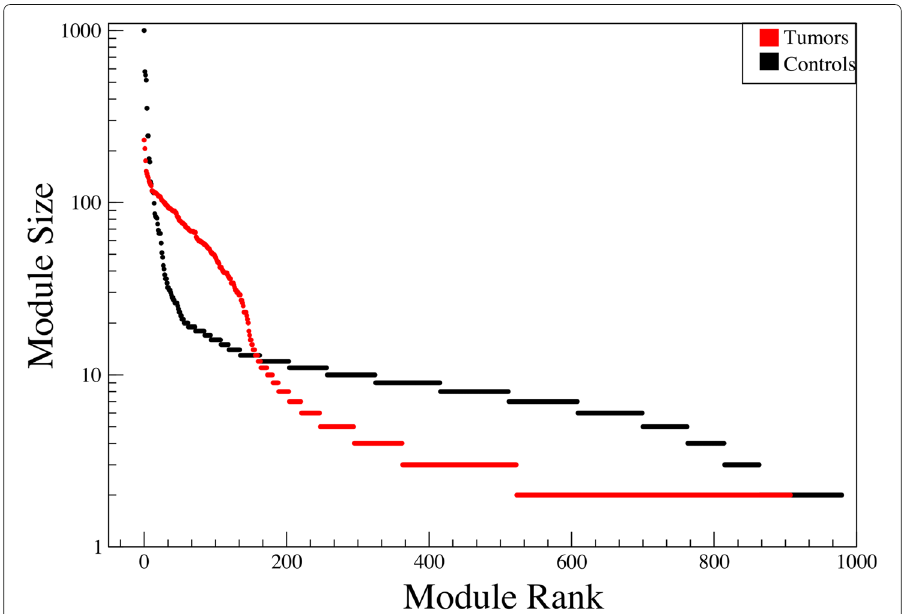
Fig. 4 Histograms of module sizes in tumor and control networks. As it can be observed, the largest modules correspond to the control network (black dots in the upper left part the figure). Also notice the different concavities in red and black